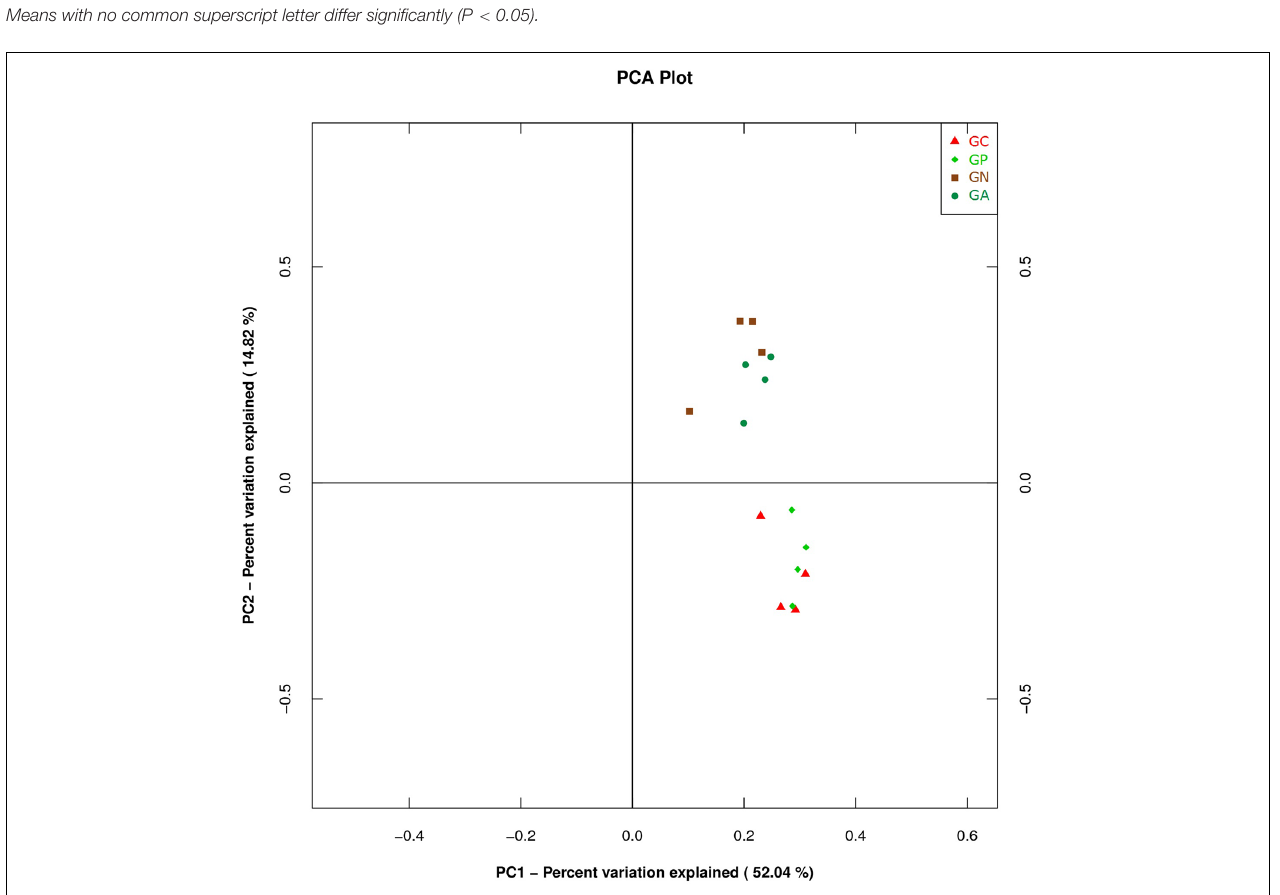
FIGURE 3 | Principal component analysis (PCA) plot based on the first and second PC of bacterial community taxonomic profiles from 16 mixed cecal samples in four groups. GC, control group; GP, phage-therapy group; GN, negative control group N; GA, antibiotic-therapy